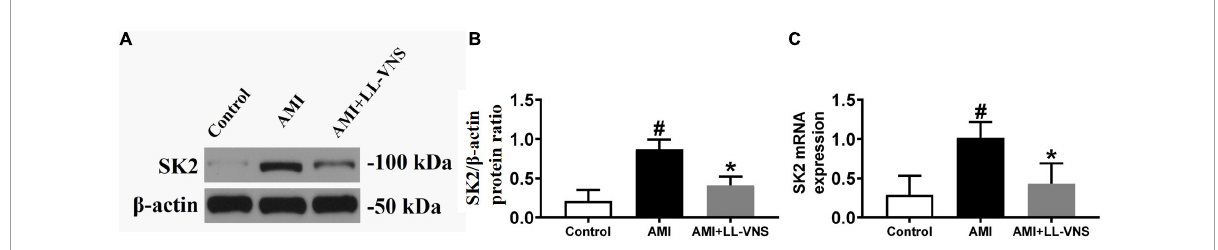
FIGURE6 Effects of low-level vagus nerve stimulation (LL-VNS) on SK expression induced by acute myocardial infarction (AMI). (A) Representative immunoblots of ventricular SK2. (B) Immunoblot analysis of ventricular SK2 protein expression. AMI contributed to a significant increase in ventricular SK2 protein expression; however, LL-VNS clearly reduced ventricular SK2 protein expression by comparison. (C) qRT-PCR analysis of ventricular SK2 mRNA expression. AMI induced an increase in SK2 mRNA expression; this was reduced in the LL-VNS group. n = 15 per group. # P < 0.05 in a comparison with the Control group. * P < 0.05 in a comparison with the AMI